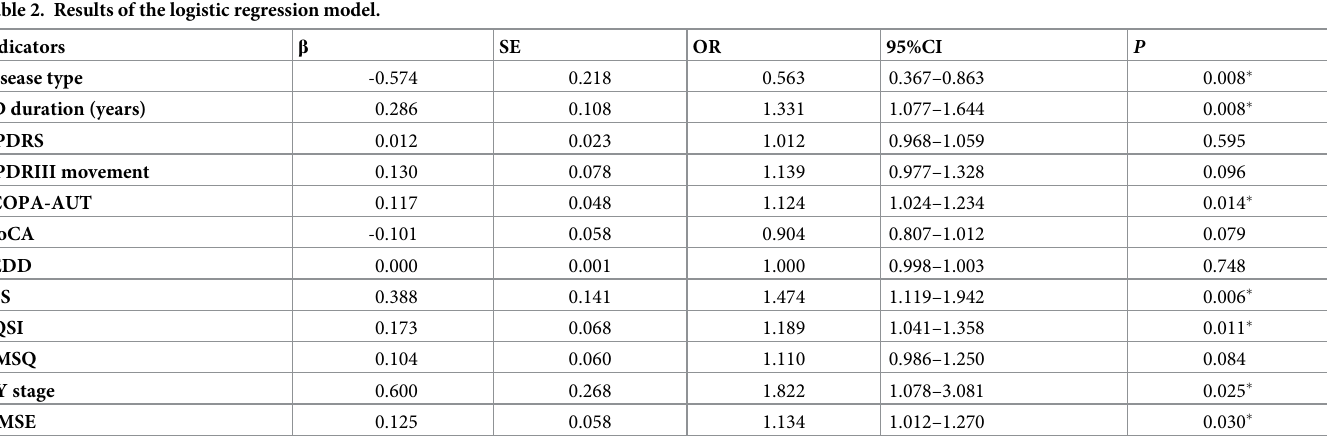
Table 2. Results of the logistic regression model.